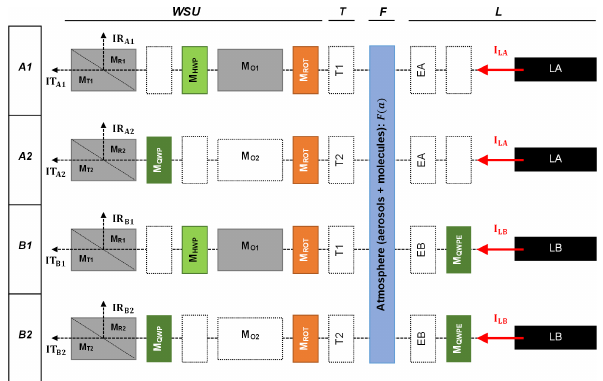
Figure 5. Sketches of the four laser-receiver configurations that are formed with the interleaved measurements of the two-laser-two- telescope setup of eVe. A1 combines the linearly polarised emis- sion of laser LA with the linear polarisation analyser WSU1. A2 combines the linearly polarised emission of LA with the circular polarisation analyser WSU2. B1 combines the circularly polarised emission of laser LB with the linear polarisation analyser WSU1. And finally, B2 combines the circularly polarised emission of laser LB with the circular polarisation analyser WSU2. See text for fur- ther